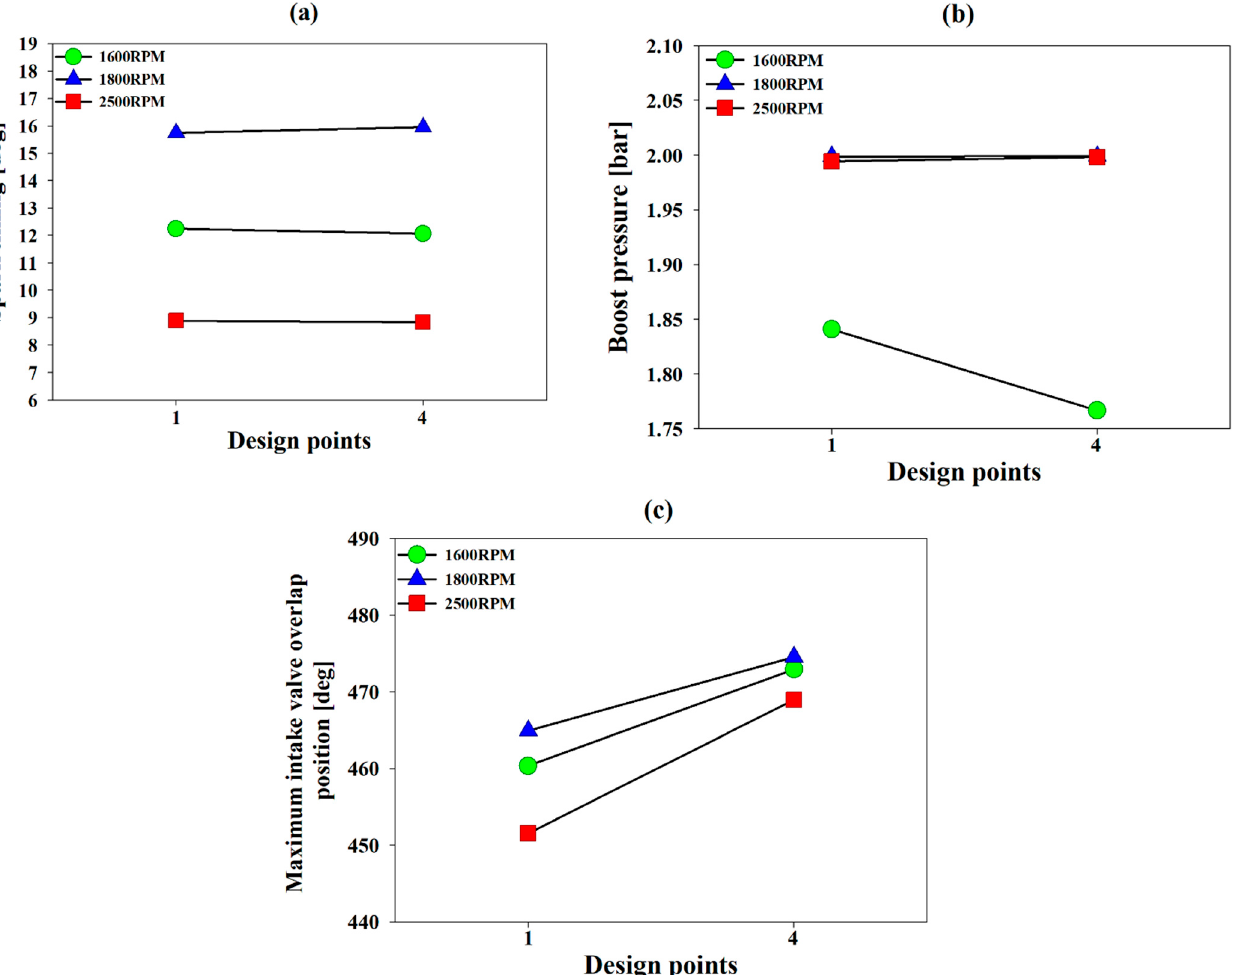
Figure 13. ( a ) Pareto optimum solution at design points 1 (maximized Brake torque) and 4 (minimized BSNOx) for specific spark timings. ( b ) Pareto optimum solution at design points 1 (maximized Brake torque) and 4 (minimized BSNOx) for specific boost pressures. ( c ) Pareto optimum solution at design points 1 (maximized Brake torque) and 4 (minimized BSNOx) for specific intake valve overlaps.